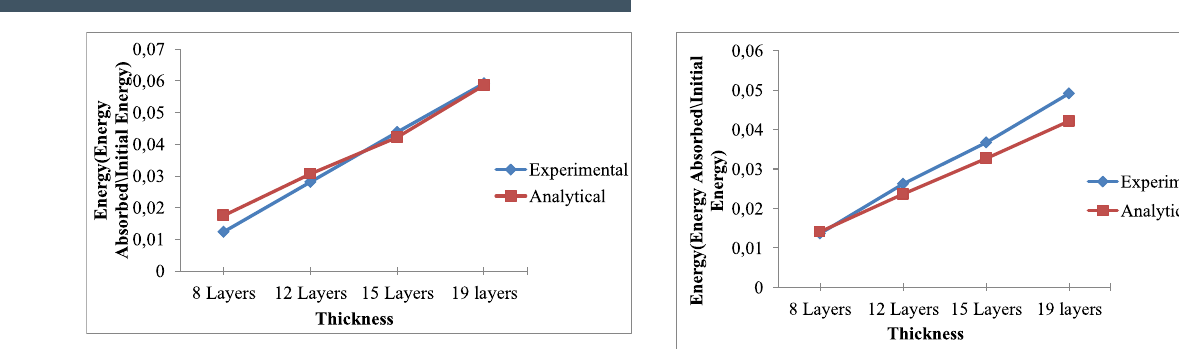
Figure 24. Comparison chart for variation of average energy ab- sorbed by different thickness plates of 30/-60/60/-30 lay- up obtained by theoretical and experimental